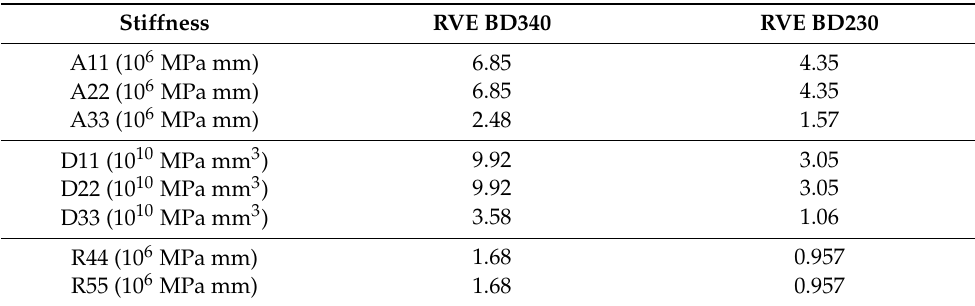
Table 3. Stiffness matrix for RVE BD340 and BD230